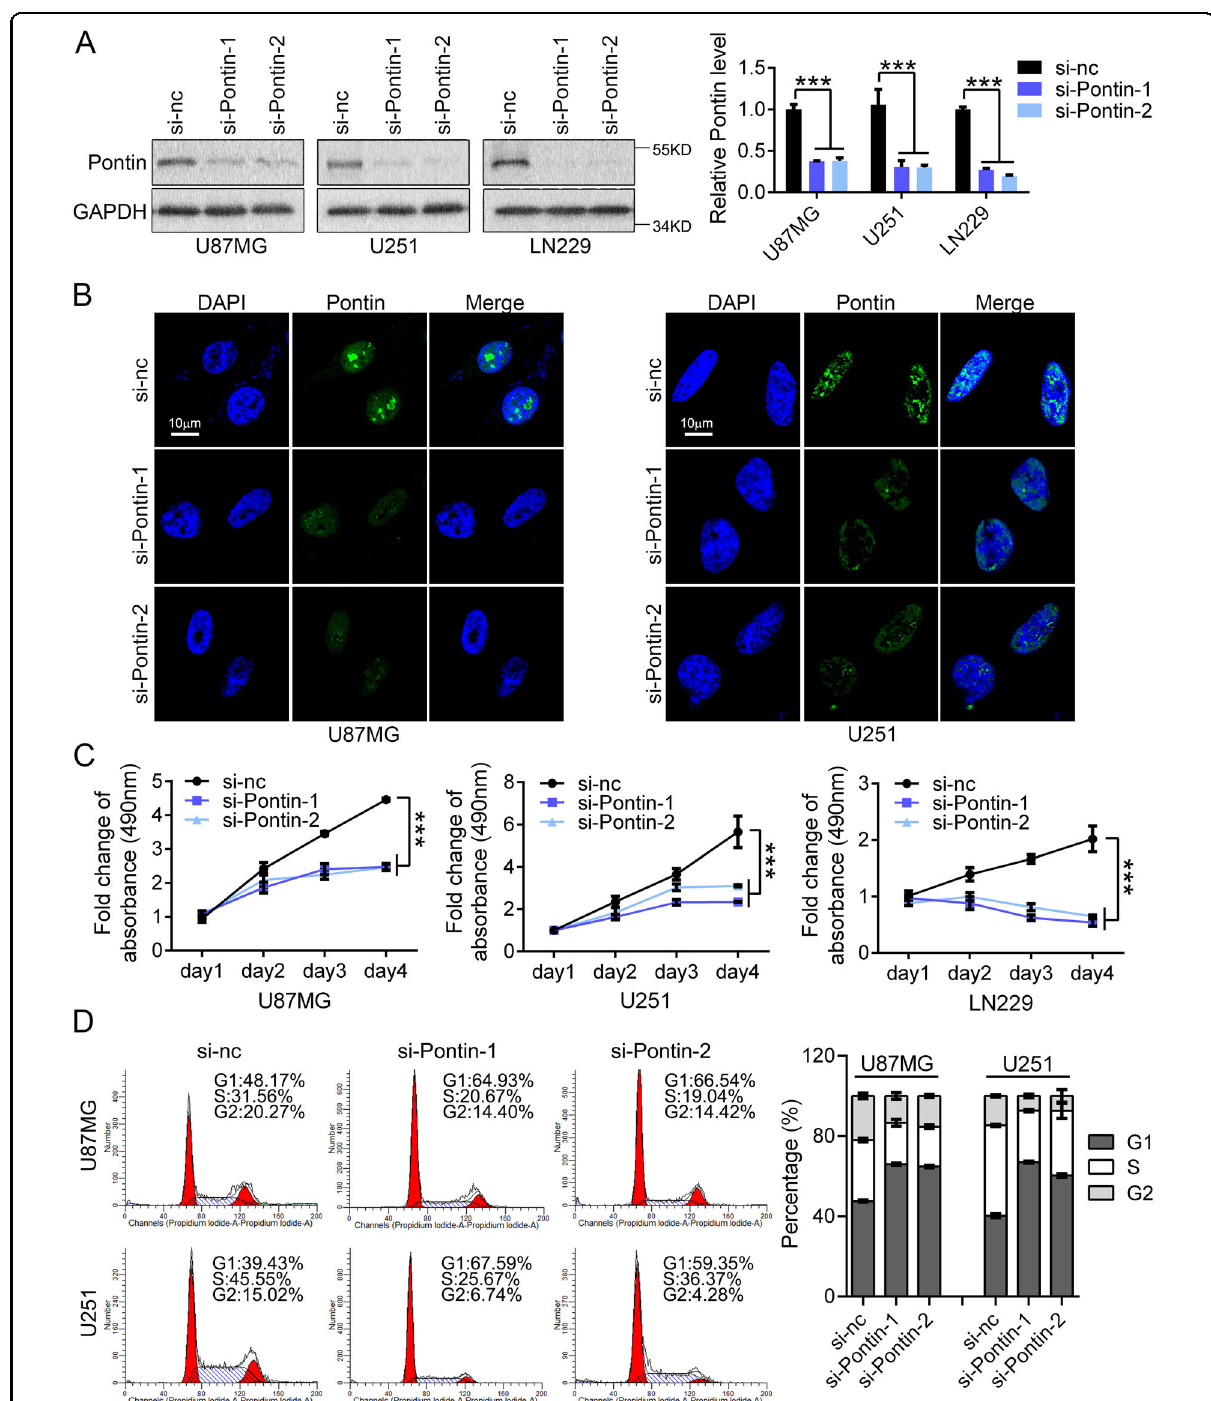
Fig. 3 Knockdown of Pontin inhibits GBM cell growth by inducing cell cycle arresting. A Western blot of Pontin expression in U87MG, U251 cells, and LN229 transfected with indicated siRNAs (si-nc, si-Pontin-1, or si-Pontin-2). B IF detection of the expression and subcellular location of Pontin in U87MG and U251 as transfected in ( A ). Scale bar, 10 μ m. C The growth curves of the indicated cells assessed by MTS assays. D FCM cell cycle analysis results of the indicated cells (left) and the percentages of cells in each phase (right). All the experiments were performed at least in triplicate. Data in ( A ), ( C ), and ( D ) are presented as the mean ± SD. *** P <